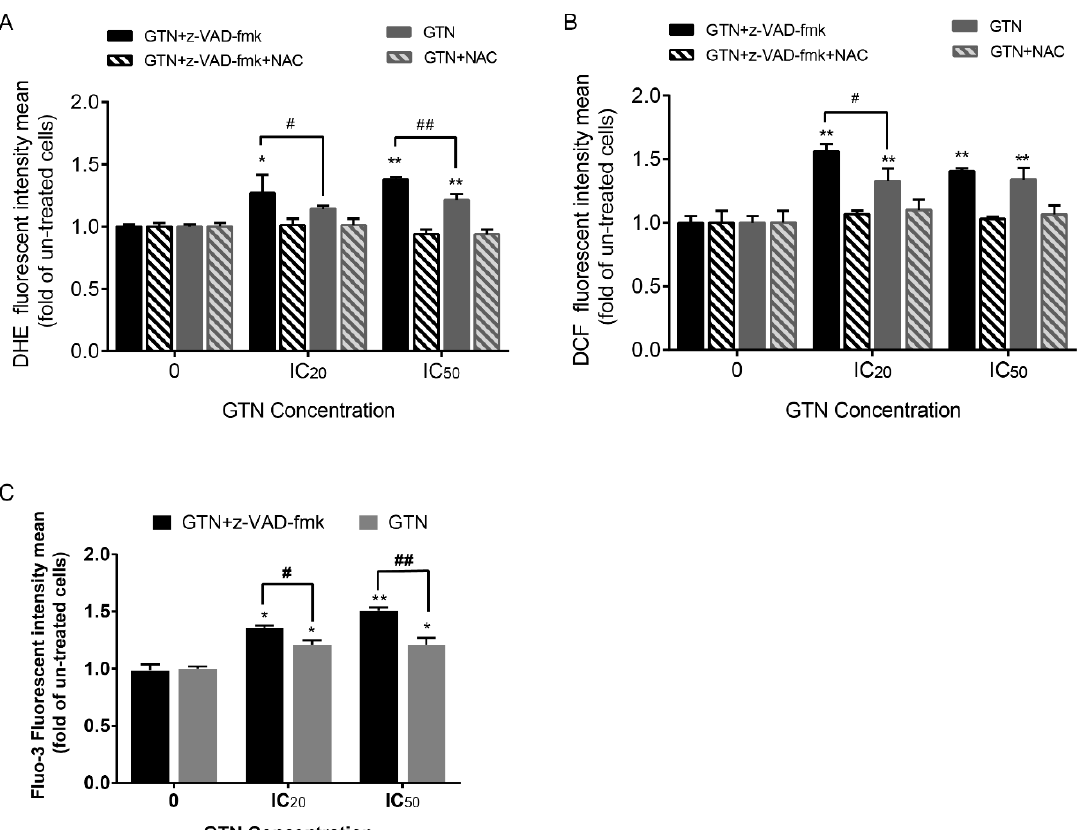
Figure 3. Endoplasmic reticulum (ER) and oxidative stress involvement in GTN and z-VAD-fmk-induced MDA-MB-231 necroptosis. ROS production was measured by dihydroethidium (DHE) ( A ), and 2’,7’-dichlorodihydrofluorescin diacetate (DCFH-DA) ( B ) represents superoxide anion radicals and hydrogen peroxide radicals, respectively, followed by fluorescent intensity detection. N -acetylcysteine (NAC) is an antioxidant, which was used to inhibit intracellular ROS production. Cytosolic calcium ion level in GTN-treated cells in the presence or absence of z-VAD-fmk, which was stained by Fluo3-AM dye and fluorescence intensity was measured by FACS ( C ). From three independent experiments in triplicate, the significance of the statistical values compared to the un-treatment group are marked with * p < 0.05; ** p < 0.01, and compared to GTN alone as # p < 0.05 and ## p < 0 . 01.